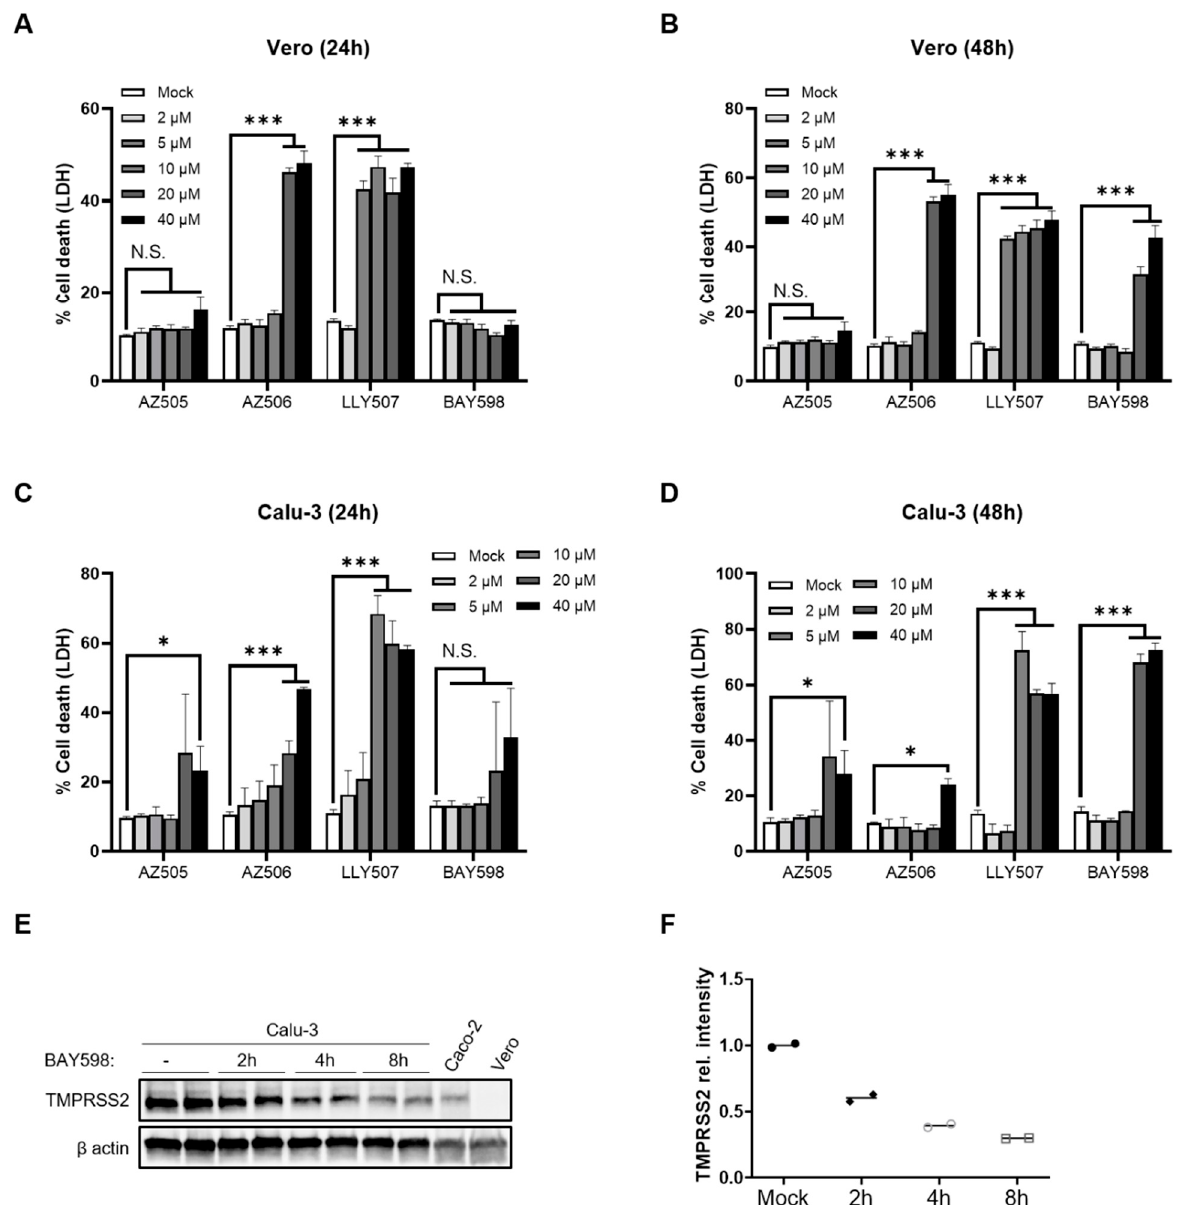
Figure 5. SMYD2 inhibition decreases TMPRSS2 expression in Calu-3 cells. ( A – D ) LDH release from Vero E6 ( A , B ) and Calu-3 cells ( C , D ) stimulated with the indicated concentrations of the respective inhibitor for 24 h ( A , C ) or 48 h ( B , D ). Experiments were performed two times and representative data are shown. *** p < 0.001. * p < 0.05. N.S., not significant. ( E ) Immunoblot analysis of TMPRSS2 in lysates of Calu-3 cells incubated with 20 µM BAY598 for the indicated time points. Caco-2 cells served as a positive control, while Vero E6 cells were used as a negative control. β -Actin was stained as the loading control. ( F ) Densitometric analysis of TMPRSS2 expression levels in Calu-3 cells.